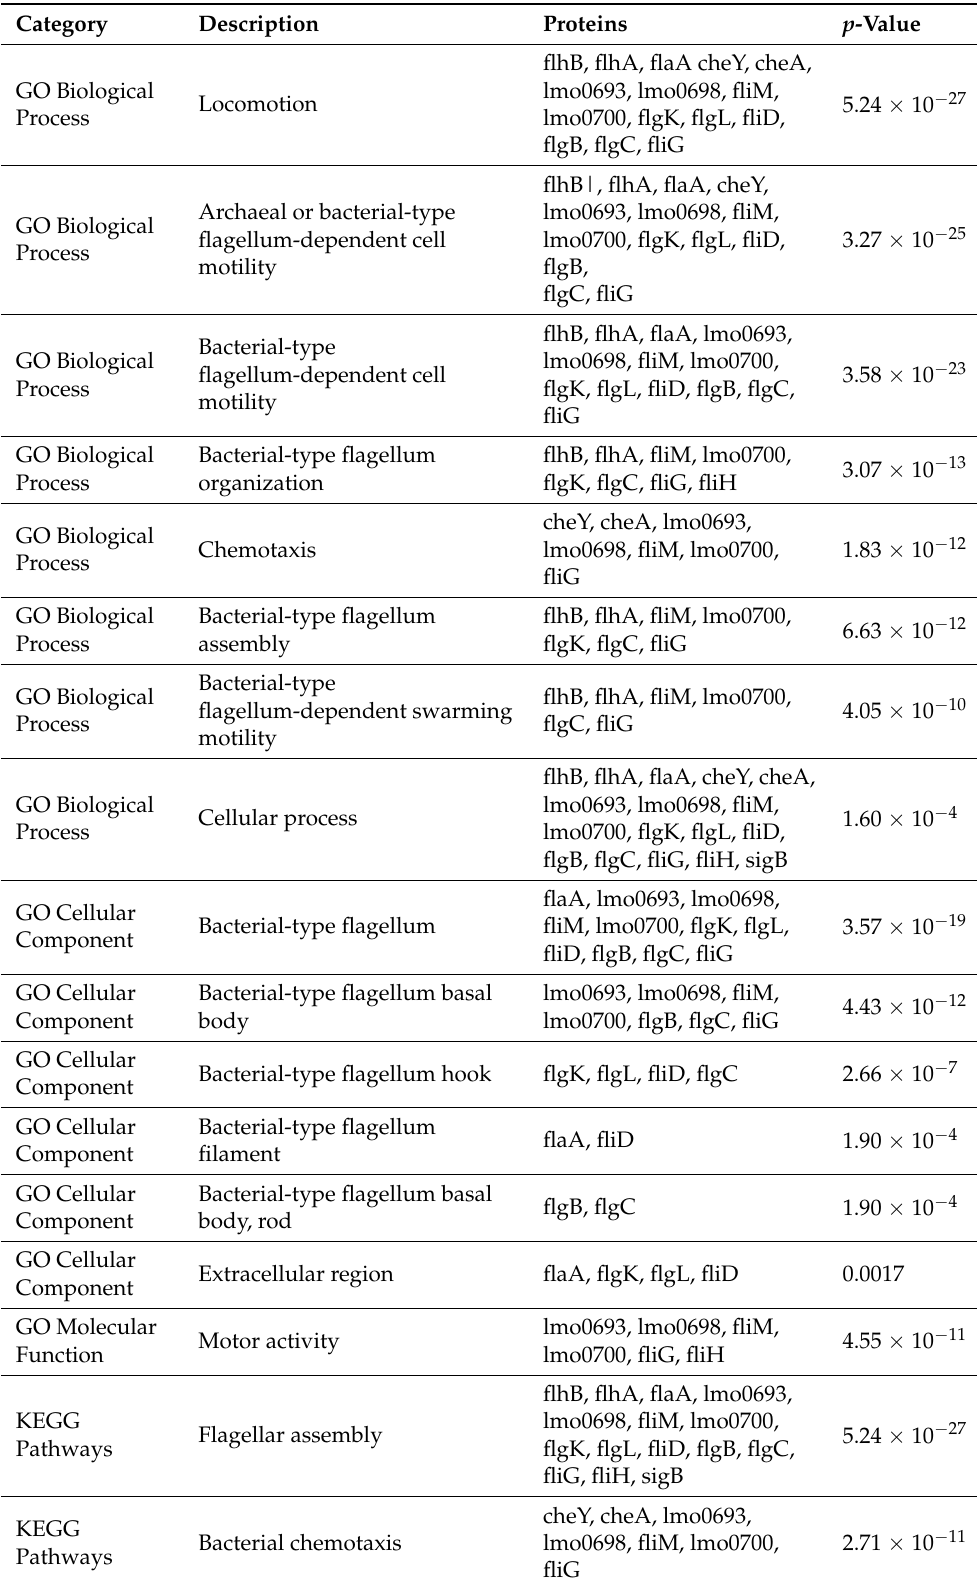
Table A6. STRING functional enrichment analysis for top 17 nodes for antibiotic